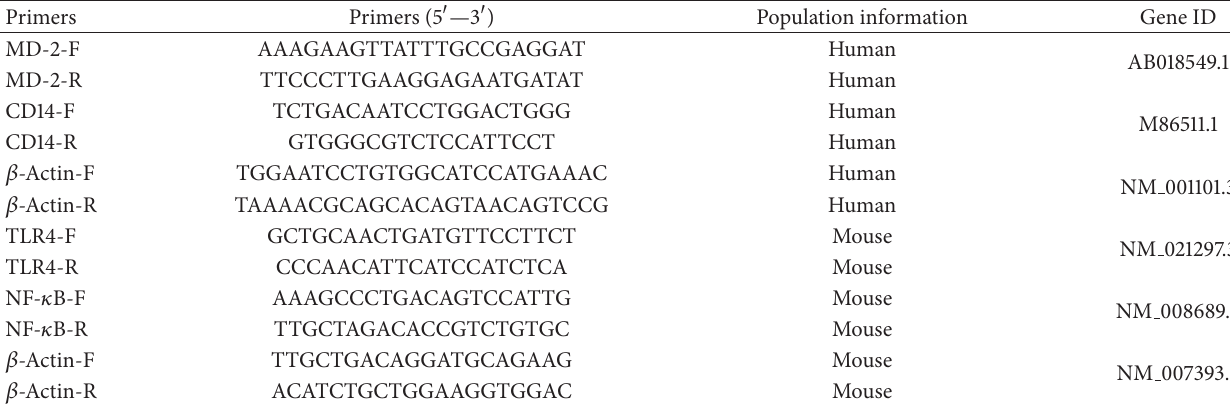
Table 1: Oligonucleotide primers used in this